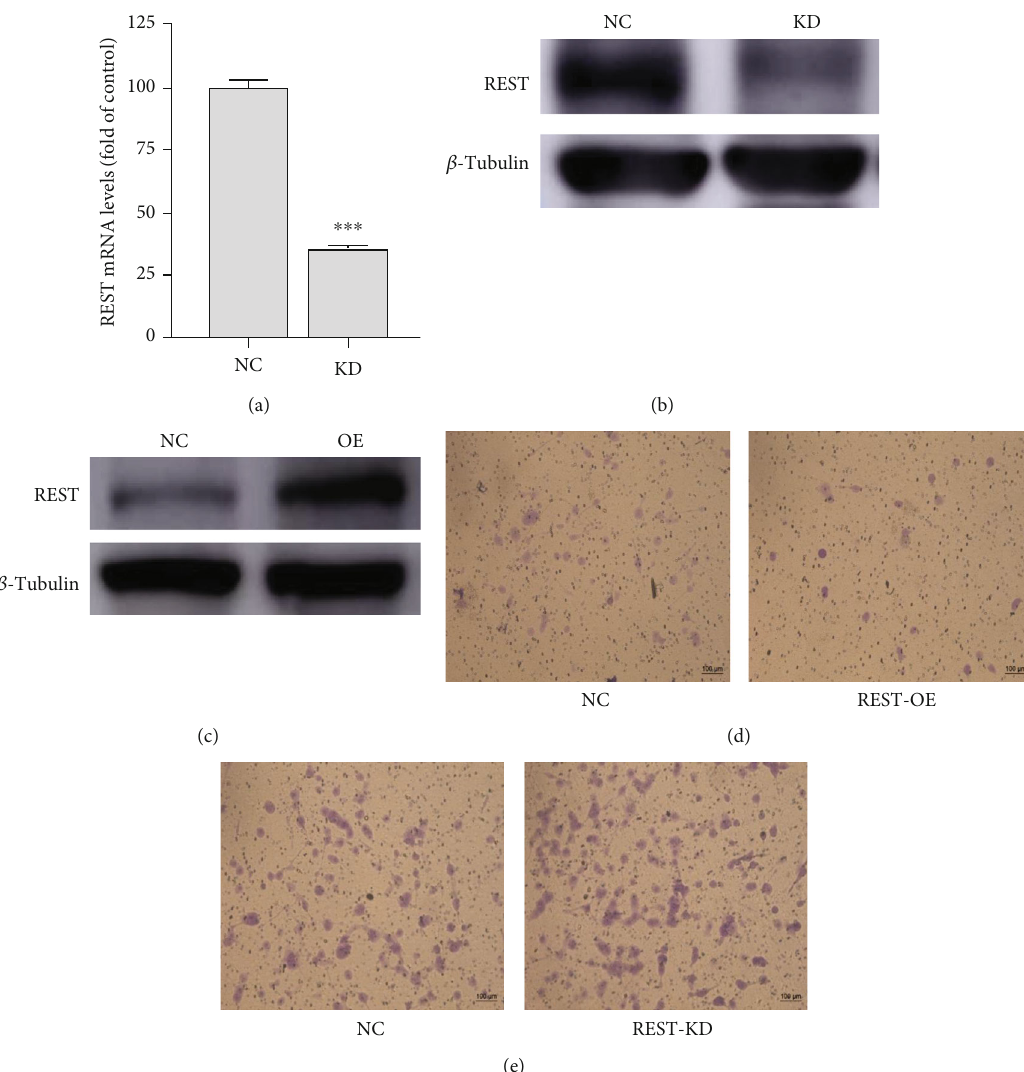
Figure 4: REST repressed BV2 cell migration. (a, b) REST was knock down by sh-RNA. (c) REST was overexpressed by recombinant plasmid transfection. (d), Overexpression of REST repressed BV-2 cell migration. (e), Knocking down of REST induced BV-2 cell migration. KD: knock down; OE: overexpression. ∗∗∗ p < 0 : 001